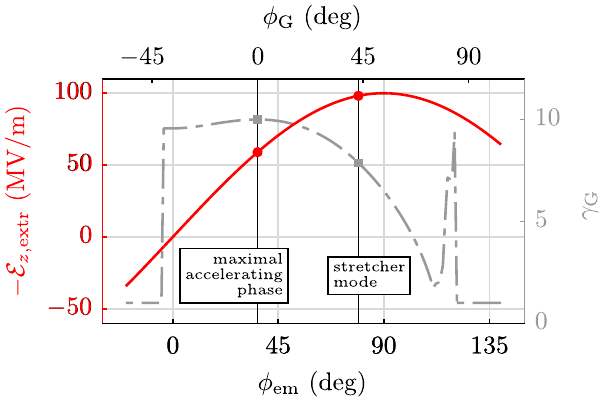
FIG. 14. Comparison of the emission phase, ϕ phase, ϕ . There is a constant offset between these two phase G definitions of about 40 deg in this example. The extraction field (red solid line) is about 60 MV = m at ϕ towards higher gun phases. The gray dash-dotted line depicts the energy gain in the